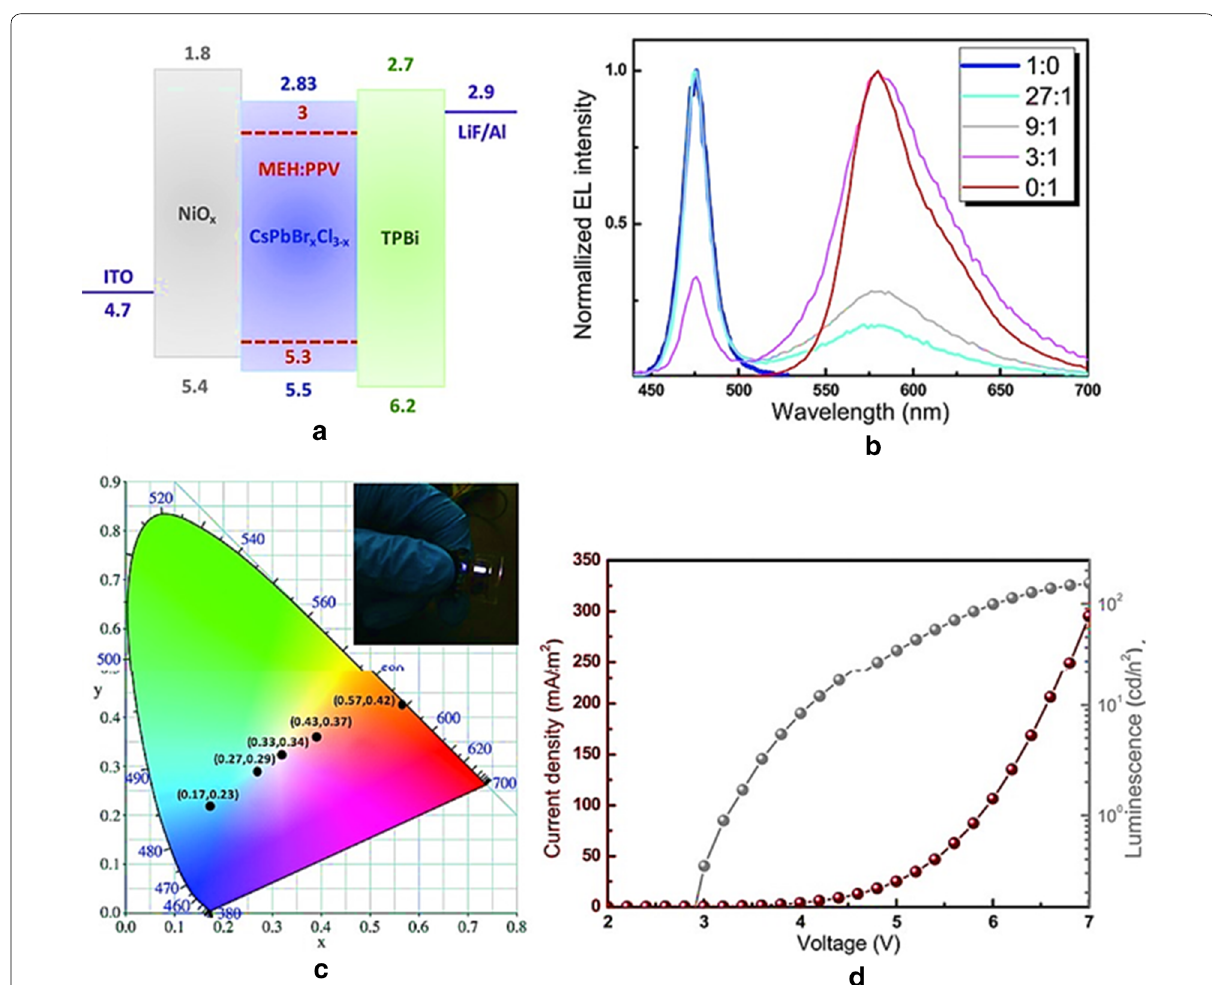
Fig. 25 a White perovskite LED energy diagram, b EL spectra of MEH: PPV/perovskite active layer for different weight ratio, c the variation of the CIE color coordinates upon varying the weight ratio [inset: image of a working white PeLED], d the current density–luminance–voltage curve of white PeLEDs (Reproduced with permission from Ref. [69] Copyright 2017, ©WILEY–VCH Verlag GmbH & Co. KGaA,